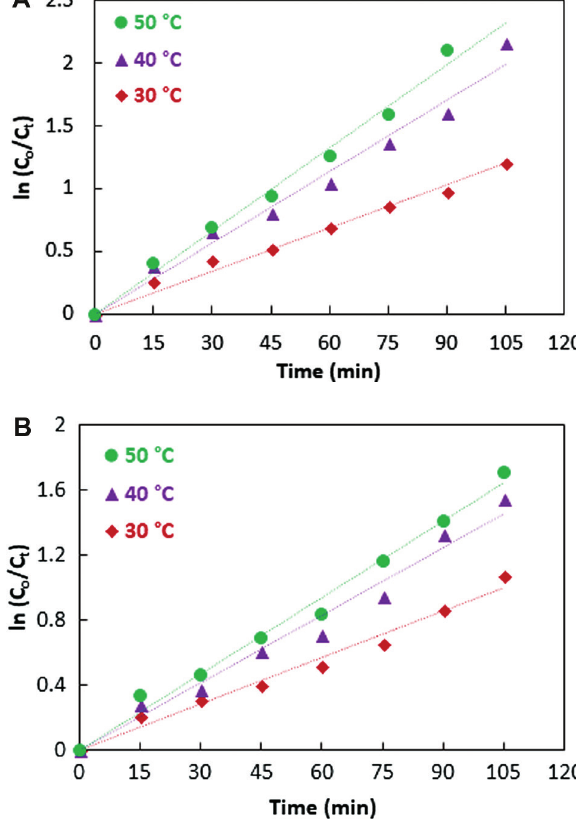
catalyzed photo degradation of 2